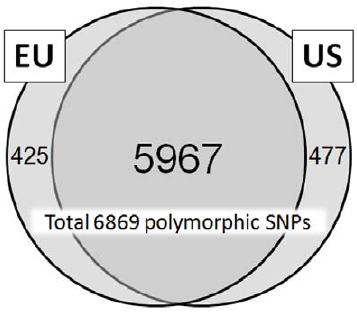
Figure 5. Polymorphic SNPs detected in EU (n=232) and US (n=477) evaluation panels from genome scans with the IPSC peach 9 K SNP array v1.